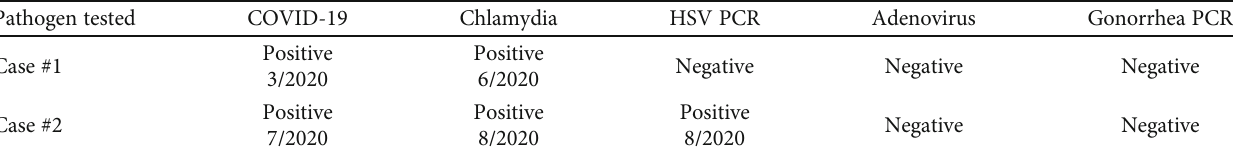
Table 1: Patient-speci fi c data that depicts coinfection of COVID-19 and chlamydia. Pathogen